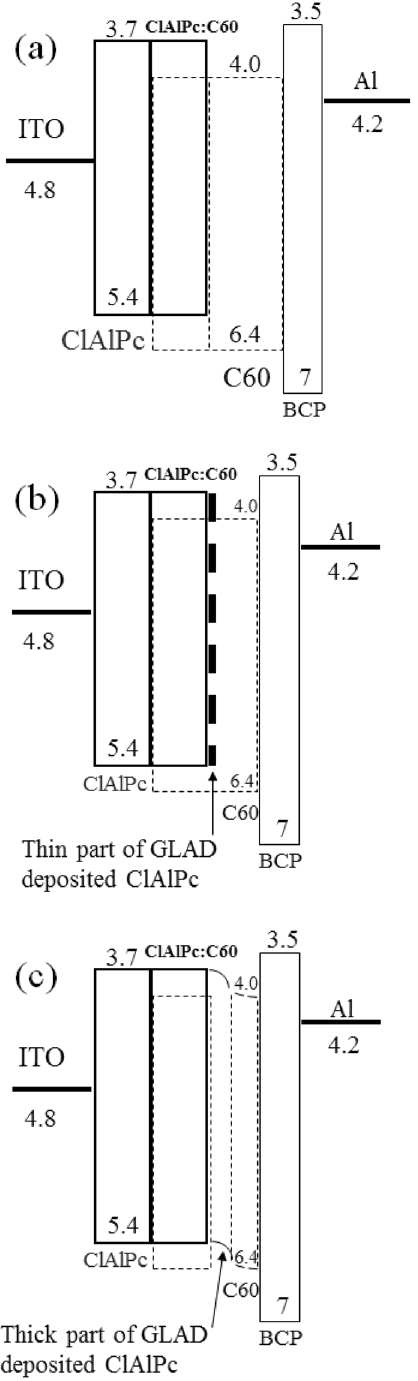
Figure 7. Schematic demonstration of energy level diagram. ( a ) Type I devices. ( b ) Thin part of GLAD ClAlPc layer in type II devices. The barrier effect of thin part of GLAD ClAlPc layer is negligible for electrons. ( c ) Thick part of GLAD ClAlPc layer in type II devices. Band bending occurs in this